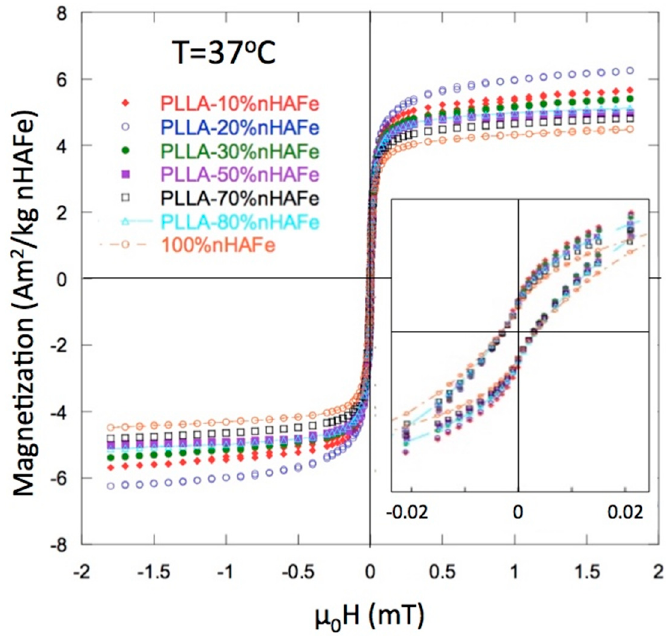
Figure 4. Magnetization curves for FeHA and poly (L-lactide) (PLLA)-FeHA scaffolds. The inset shows the close-up of the “wasp-waist” loops described in the text.